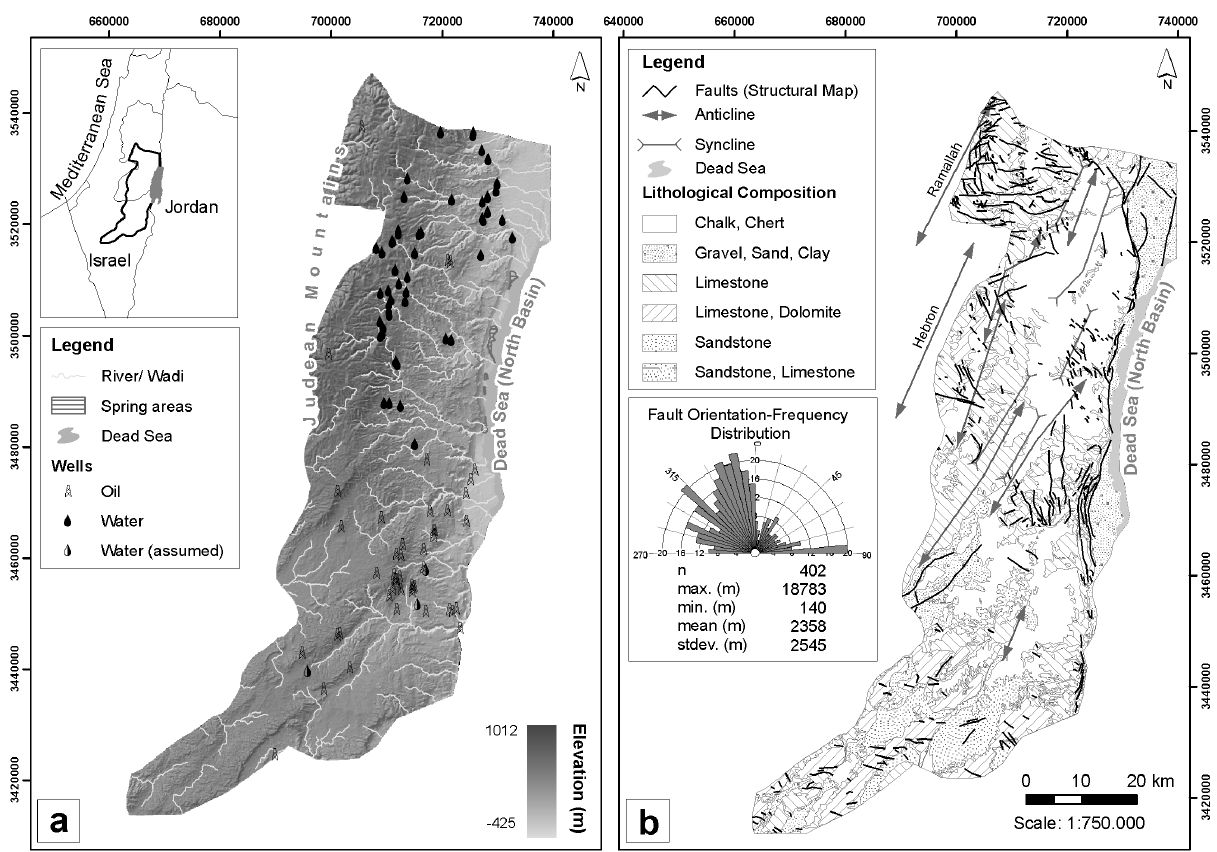
Fig. 4. Describes (a) topographical features of the study area (“Water wells assumed” refers to three water wells in the southern area taken from (Arad, 1966; Vengosh et al., 2007) and gives (b) a lithological and structural overview (Projection: UTM WGS 84 Zone 36 ◦